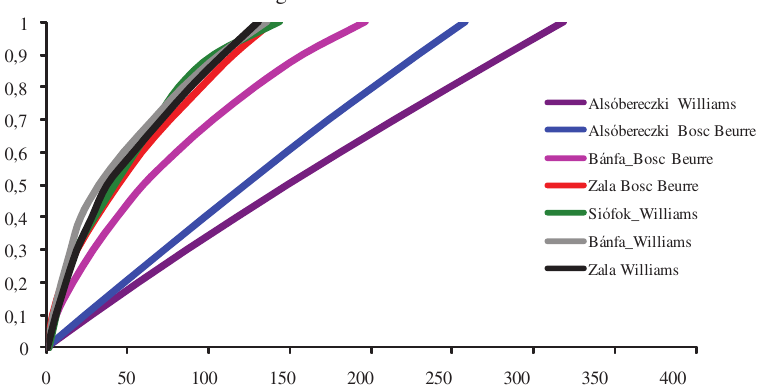
Figure 5. Illustration of second degree stochastic dominance for the yield of the examined four plantations and for the two pear